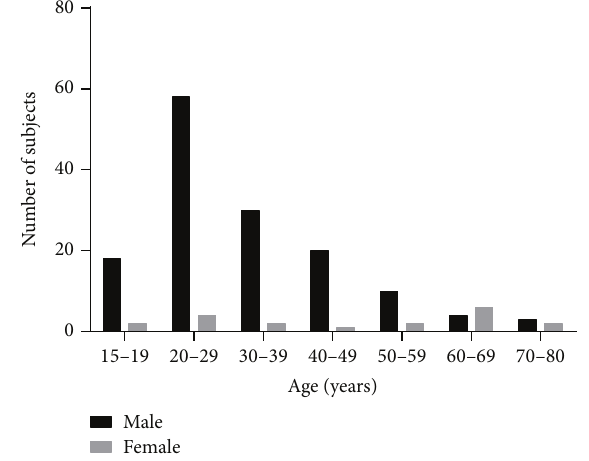
Figure 1: Subject demographics. Orbital fractures were more fre- quentinmenandpeakedinthethirddecadeoflife.142subjectswere male with an average age of 32 [95% CI 30 − 35] years. There were 19 female subjects with an average age of 49 [95% CI 39–59] years. The difference in age of presentation was significant ( 𝑃 < 0.001 ). Figure 2: Fisher plot of possible predictors of ocular injury in Table 1: Group characteristics. orbital fractures not requiring emergency surgery. Age, sex, type of fracture, extent of fractures within the orbit, and presence of distal facial fractures were not statistically associated with the presence of significant ocular injury. Habitually corrected visual acuity was significantly associated with the presence of significant ocular injury (OR 49 [95% CI 11–217, 𝑃 < 0.0001